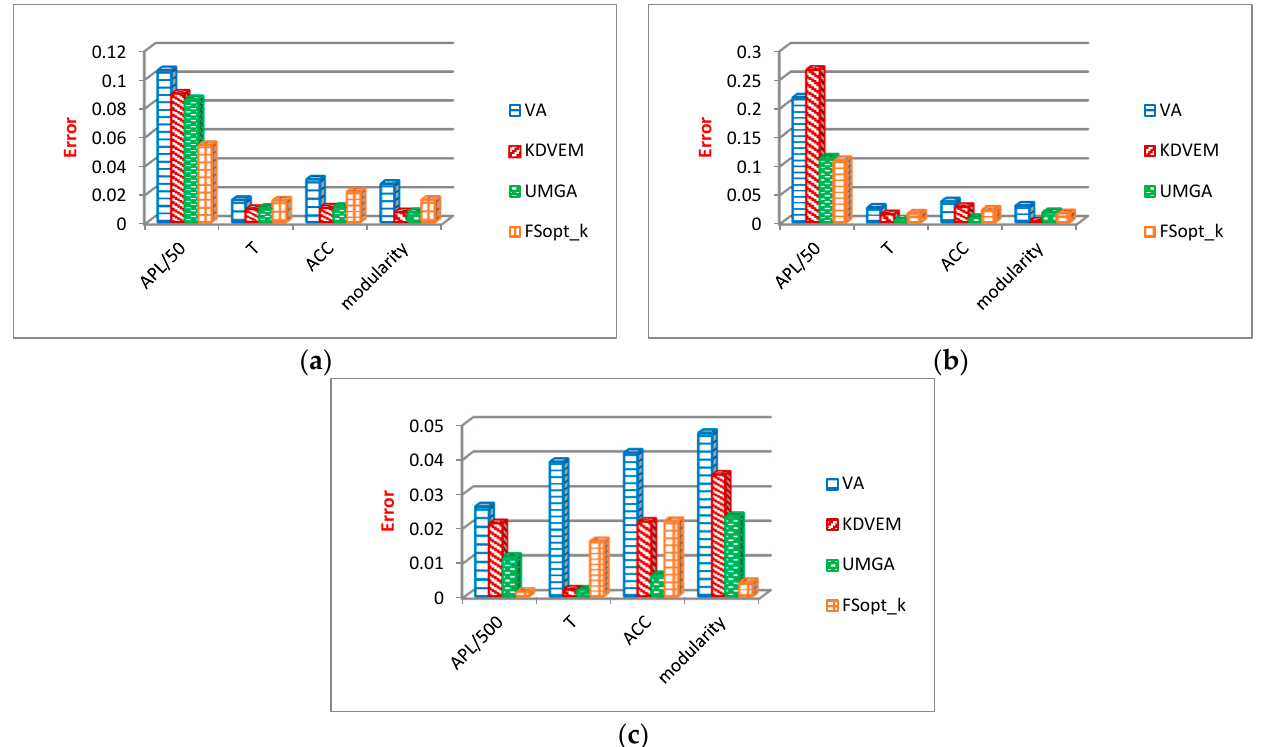
Figure 10. Comparison of error values of the algorithms on power grid dataset for (a): ℒ = 0.05 , (b): ℒ = 0.1 , and (c): ℒ = 0.2 .